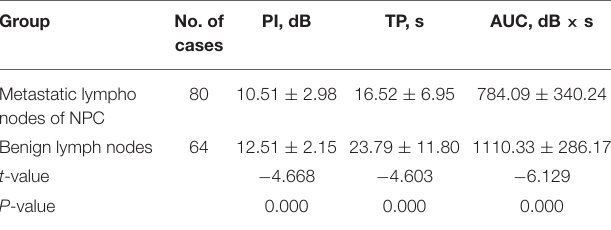
TABLE 2 | Comparison of the parameters in the contrast-enhanced ultrasound (CEUS) between benign and metastatic lymph nodes in NPC patients.